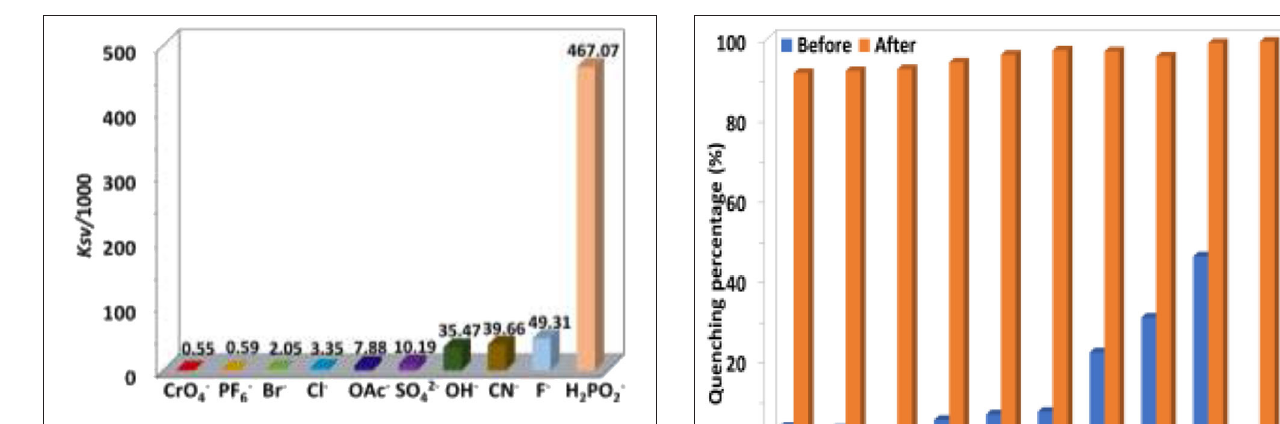
FIGURE 6 | NIR emission quenching efficiencies of 1 to anions.